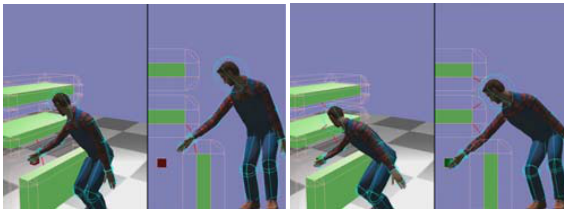
Figure 2. The posture of the virtual human avatar is driven by motion capturing the user [8]; the posture reconstruction is combined with collision avoidance owing to damping constraints (red lines)